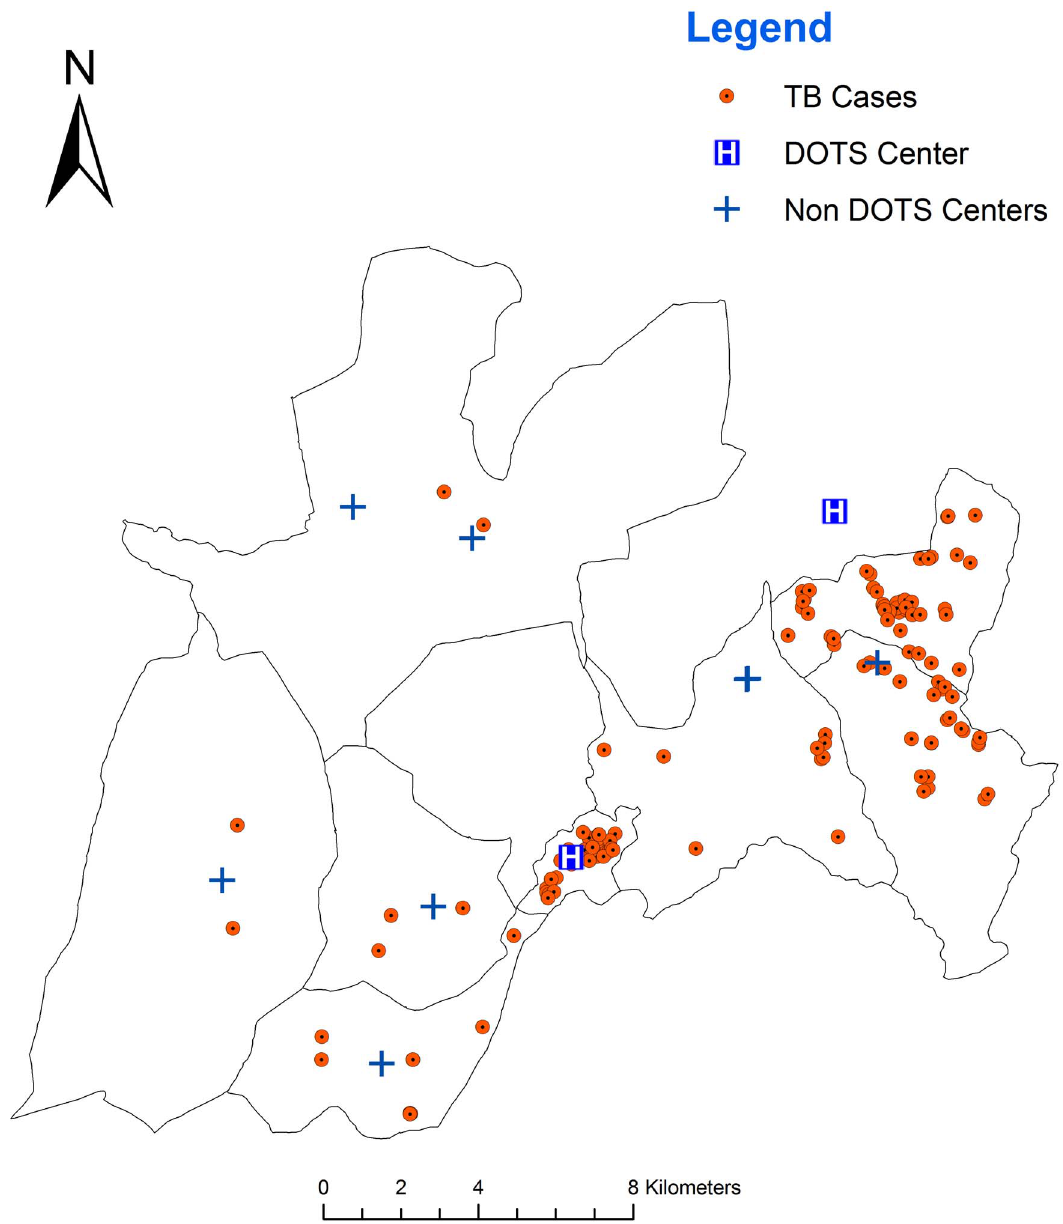
Figure 2. Spatial distribution of TB cases, health centres and health posts in Dabat, Ethiopia, 2012.